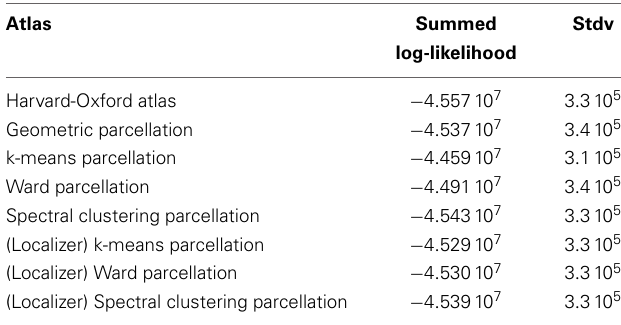
Table 1 | Summed log-likelihood of the Localizer data under different spatial models (the higher, the better): brain atlas (left), parcellation on the Localizer dataset (middle), parcellations from the HCP data (right).